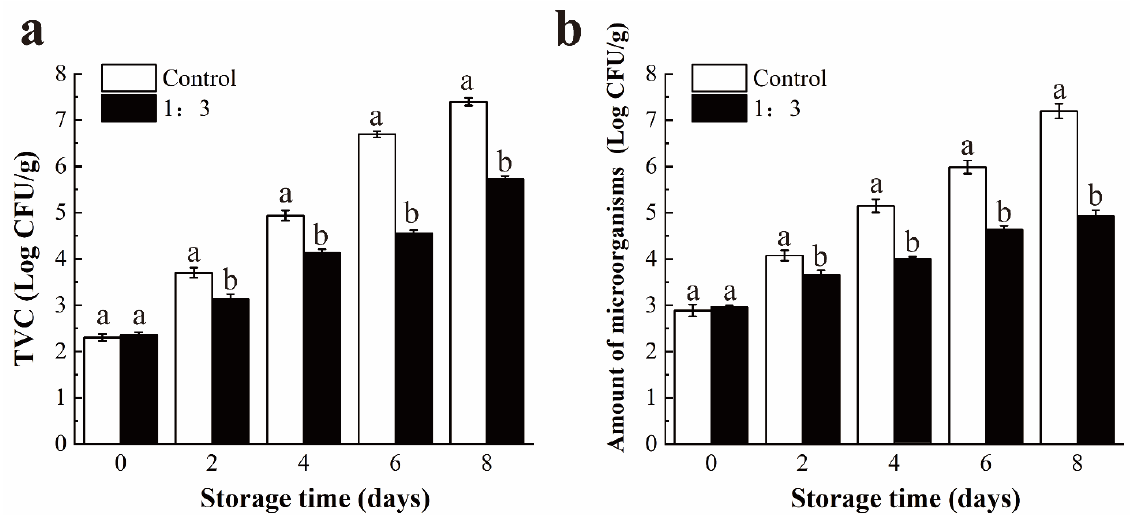
Figure 9. Changes in total viable counts (TVC, Log CFU/g) ( a ) and antibacterial application against V. parahaemolyticus of salmon at 4 ℃ for 8 days ( b ). Different letter marks on the same day indicate significant difference ( p < 0.05). Control = coated with distilled water; 1:3 = coated with XG and liposome (1:3, v / v ) mixed solution. XG: xanthan gum.